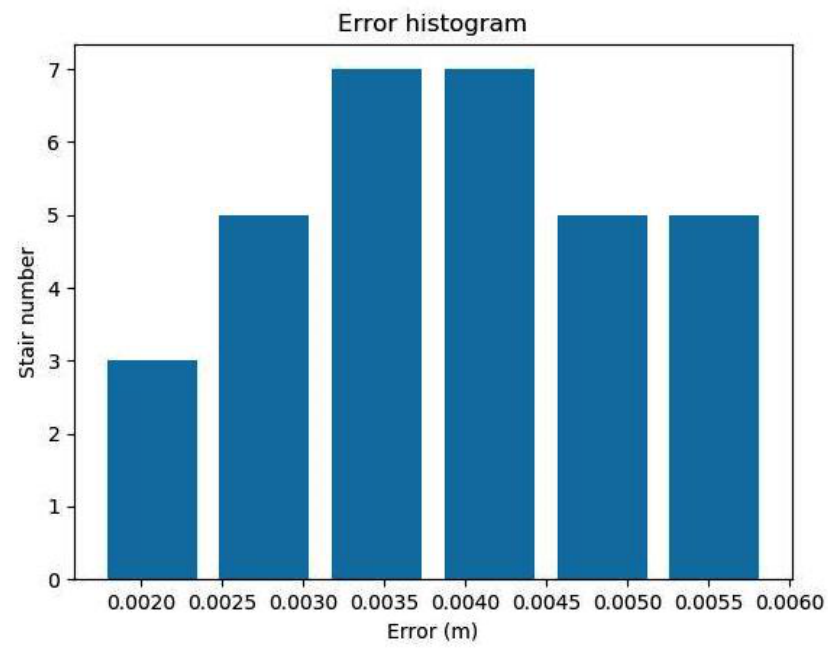
Figure 10. The histogram of the 32 stairs’ size error.